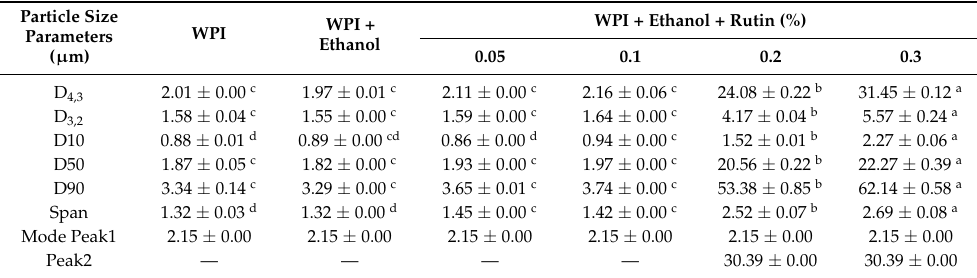
Table 2. The effects of ethanol (15% v / v ) and different levels of rutin (0.05%, 0.1%, 0.2% and 0.3% w / v ) on the particle size parameters of WPI. “—” means peak2 is not detected. Means in the same row with different letters (a–d) differ significantly ( p < 0.05).